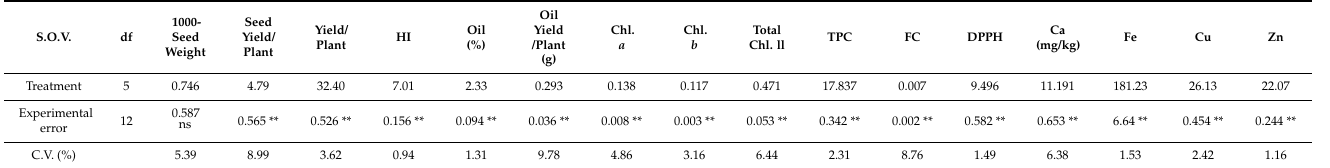
Table 3. Analysis of variance for the quantitative and qualitative traits of Syrian cephalaria as influenced by organic and chemical